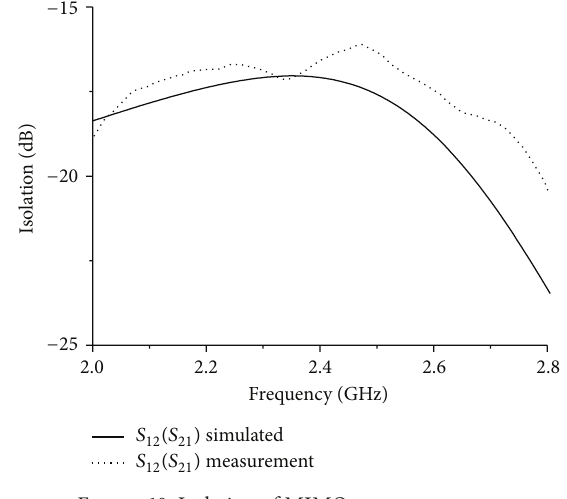
Figure 10: Isolation of MIMO antenna system.